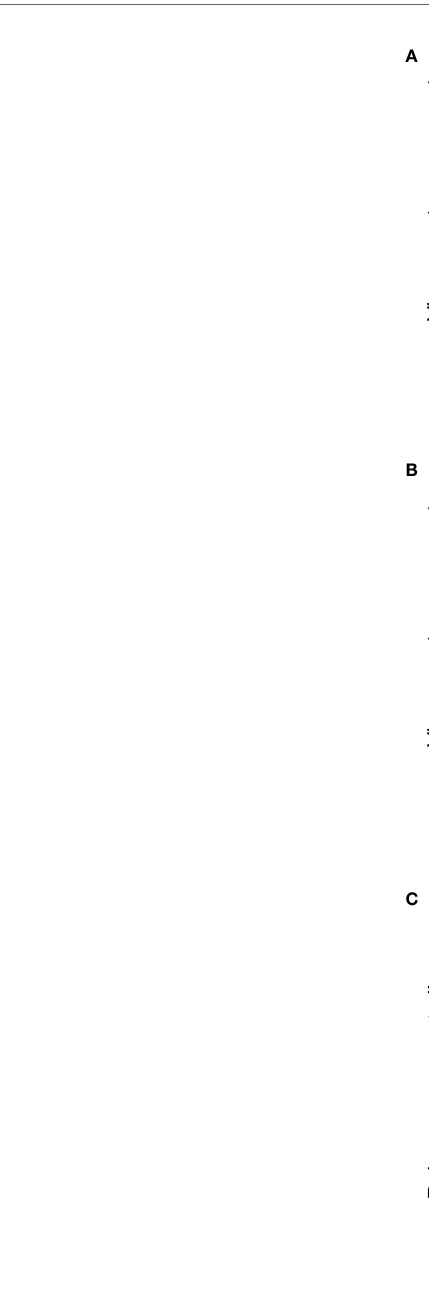
FIGURE 3 | Clodronate treatment decreases the in vivo enhanced nociceptive responses to vaginal distension in a model mice of vulvodynia. (A) Visceromotor response (VMR) to vagina distension (VD) was signi fi cantly increased in animals treated with Complete Freud Adjuvant (CFA), compared to control (saline) treated animals (**p ≤ 0.01 at 30mmHg; *p ≤ 0.05 at 40mmHg, ***p ≤ 0.001 at 60, and ****p ≤ 0.0001 at 80mmHg, generalised estimating equations followed by LSD post hoc test, from N=8-9 mice). Data expressed as area under the curve of the corresponding EMG signal. Data represent Mean ± SEM. (B) Treatment with clodronate liposomes in mice that received CFA (CFA + Cl) signi fi cantly reduced the elevated VMR to vagina distension present in mice that received CFA alone (CFA), normalising the responses to control mice (saline, N=8). (^ p ≤ 0.05 at 20, 40, 60 and 80 mmHg, generalised estimating equations followed by LSD post hoc test, from N=8-9 mice). Data expressed as area under the curve of the corresponding EMG signal. Data represent Mean ± SEM. CFA and Saline groups are the same as presented in (A) . (C) Grouped data expressed as the total area under the curve (AUC) of the VMR to VD showing signi fi cantly increased responses in CFA treated mice compared with control saline mice. Treatment with clodronate liposomes (Cl) reversed the increased responses present in CFA animals back to control saline levels (Ordinary one-way ANOVA followed by Bonferroni post hoc test, from N=8-9 mice). Each dot represents the total AUC from an individual animal. Data represent Mean ±